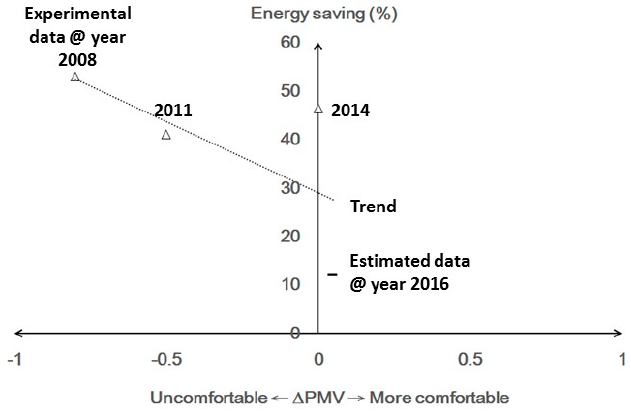
Figure 4. The aforementioned experimental data and the estimated data of energy savings of air conditioner through the development of fluidic sensors with occupancy detection technology from 2008 to 2016.